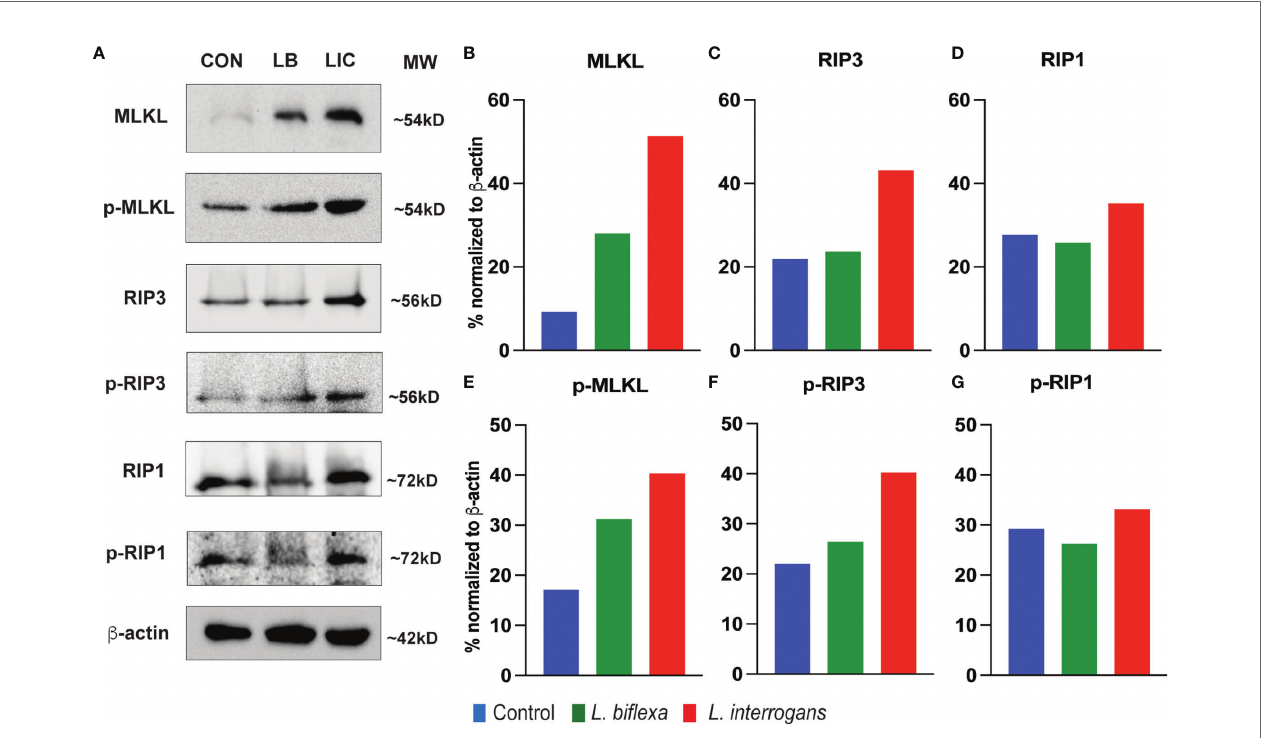
FIGURE 5 | Protein expression of key biomarkers of necroptosis at 24h post infection. (A) represents immunoblots of protein lysate (whole spleen cells) from uninfected Control (CON), nonpathogenic L. bi fl exa (LB) and pathogenic L. interrogans (LIC) infected groups. (B – G) represents the densitometric histograms normalized to b -actin expression control using ImageJ software. Legend: MLKL (Mixed Lineage Kinase Domain-Like protein), Receptor Interacting Serine/Threonine Kinase (RIP1 and RIP3); p,